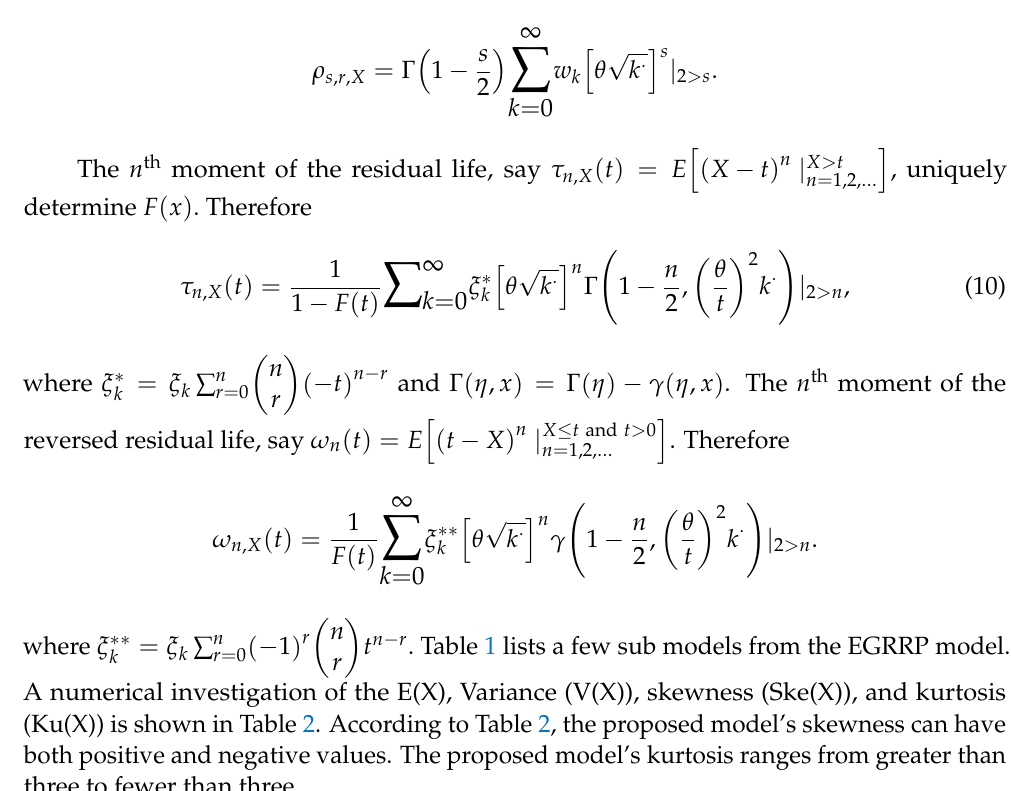
t n − r . Table 1 lists a few sub models from the EGRRP model.